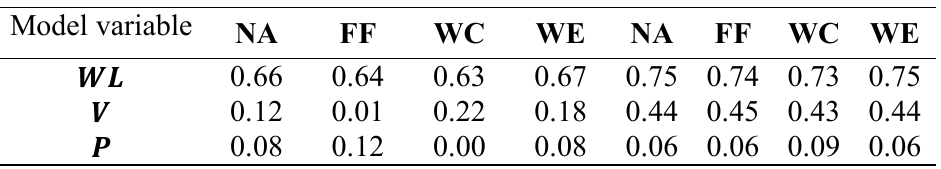
Table A1. Percent error in the variation and discrepancy coefficient values of water level (WL), reservoir volume (P), and population (P) for the different water management strategies (NA: No Actions; FF: Fighting Floods; WC: Water Conservation; WE: Water